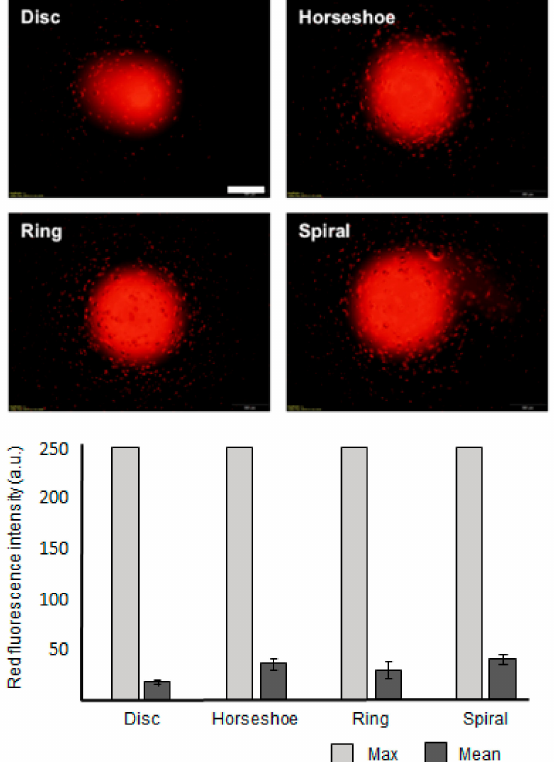
Figure 5. Pharmaceutical releasing ability of the discotic, horseshoe, ring, and spiral microparticles. Rhodamine was selected as the modeled pharmaceutical. Inset images show the diffusion of rho- damine onto agarose sheets after 10 min. The error bars represent the standard deviations ( n = 10) (scale bar: 500 µ